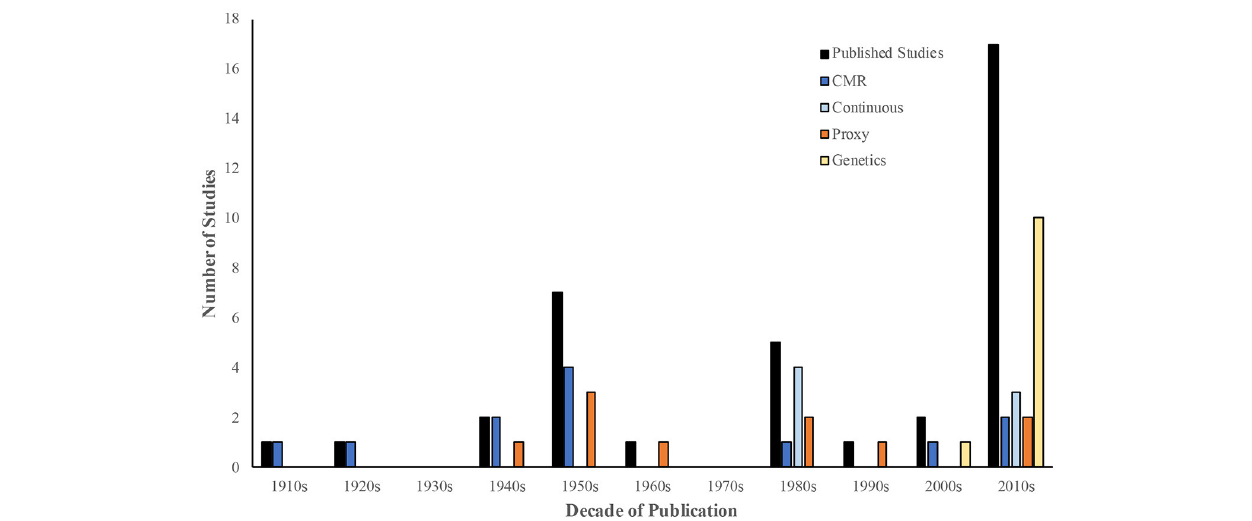
FIGURE 2 | The number of unique published studies ( n = 37) included in the review by decade of publication. Within each decade, the number of studies employing direct (Capture-Mark-Recapture (CMR) and continuous tracking), and indirect methods (proxy measures and genetics-based tools) to assess rat movement are